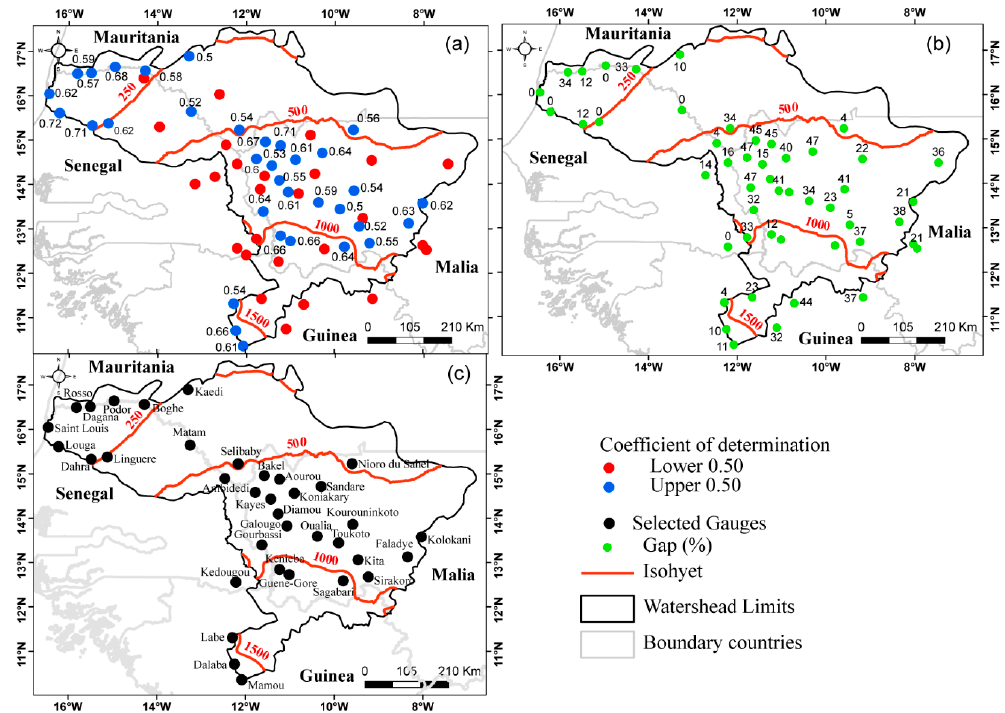
Figure 2. ( a ) Coefficient of determination between the observed annual rainfall and calculated by the regional vector method, ( b ) percentage of gap in the data series by station, ( c ) stations selected for the study.